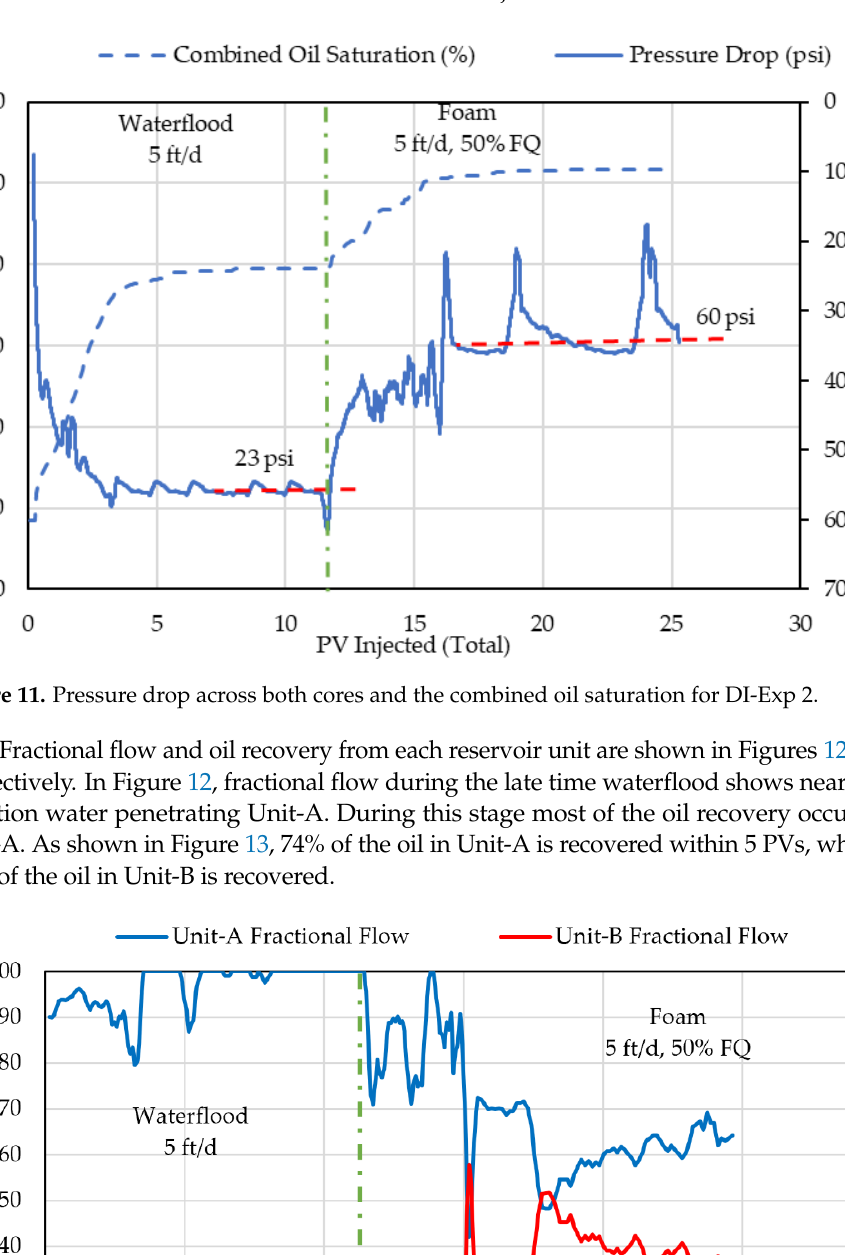
Figure 13. Oil recovery (%) from Unit-A and Unit-B cores for DI-Exp 2. Fractional flow rapidly changes during the foam injection stage. First, considering the period of 11 – 15 PVs, the liquid fractional flow reduces from 100 to 80% through Unit- A or increases to 20% through Unit-B. This is associated with a steep rise in oil recovery from Unit-B (from 46 to 76%). This production increase is due to foam generation in Unit- A diverting more gas and water to Unit-B leading to better sweep efficiency. A sharp rise in production from 74 to 85% also occurs in Unit-A. Such an increase in production from this flow unit is directly attributed to foam induced gas mobility reduction (indicated by the pressure drop buildup shown in Figure 11). The average fractional flow continues to decrease to around 60% in Unit-A beyond 15 PVs as foam continues to develop stronger